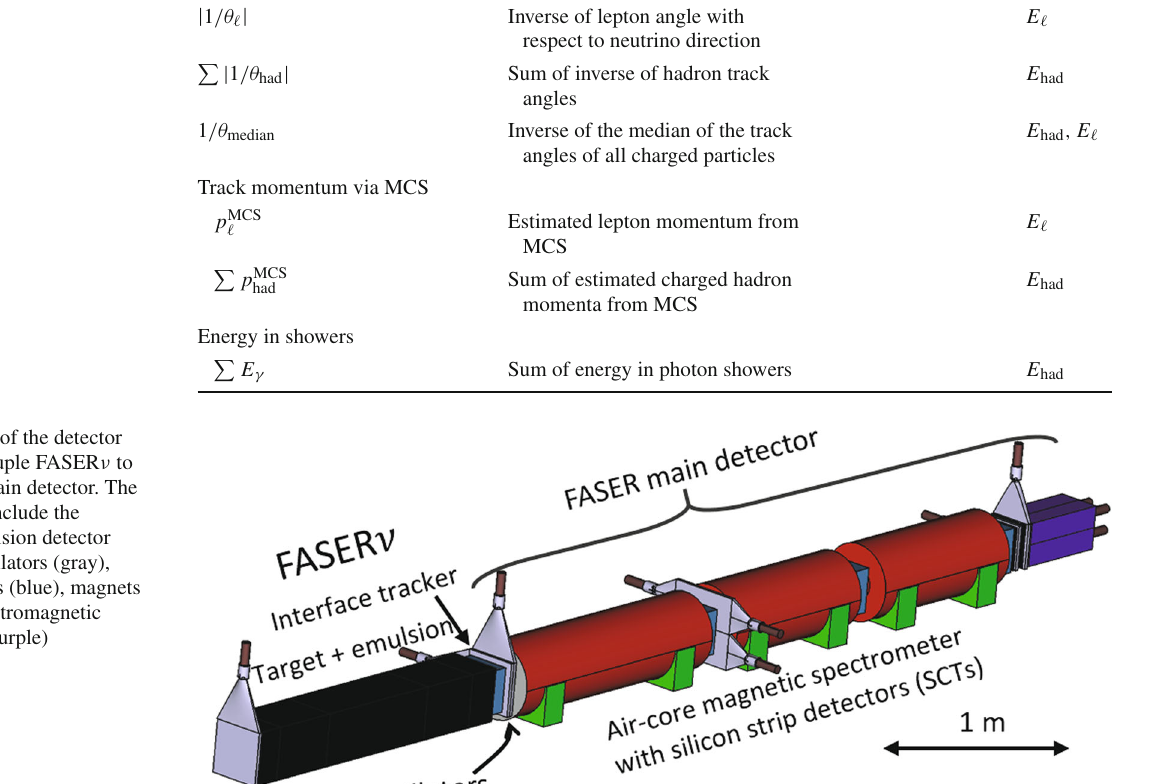
Table 3 Inputs for the ANN algorithm. For the momentum estimates using the MCS method, we assume a position resolution of 0 . 4 µ m. For the